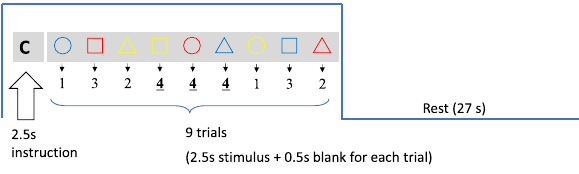
Figure 3. Task sequences. For all three tasks, there were six task blocks. Each task block (29.5 s) consisting of nine trials was followed by a rest period (27